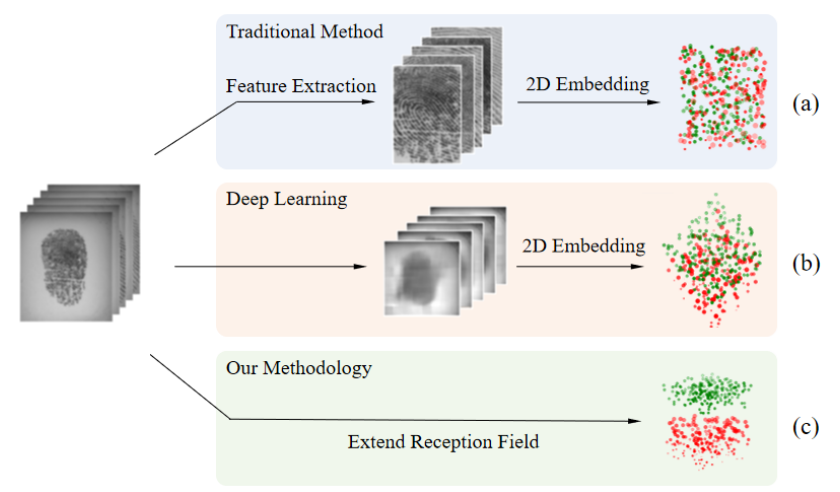
Figure 1. General automatic gender classification methods preview. ( a ) Traditional method for gender feature extraction; ( b ) Deep learning method for gender feature extraction; ( c ) We propose a feature extraction method of fingerprint that takes global features into